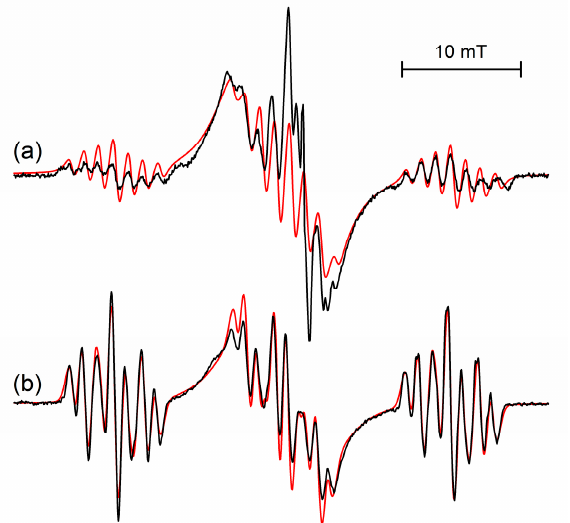
Figure 3. Comparison of the EPR spectra of the radical cations of ( a ) s-trioxane at 50 K and ( b ) 1,3-dioxane at 95 K observed after irradiation of 0.1 mol% CF 3 CCl 3 solutions. Spectral simulations are shown with red lines. Parameters of s-trioxane are given in Table 1 (50 K), data for 1,3-dioxane are a (H)/mT = 14.6 (1H), 13.7 (1H), 2.45 (2H), 1.0